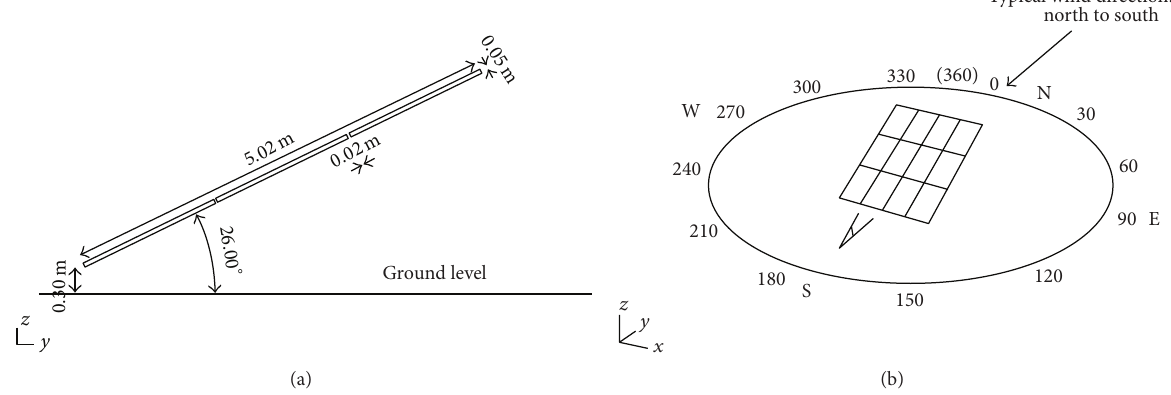
Figure 3: (a) Solar panels side view inclined at angle 𝛽 = 26.0 ∘ and (b) schematic diagram of the arrayed solar panels set. Longest panel axis is set parallel to north-south direction. The north is 0.0 ∘ . Azimuthal angles in